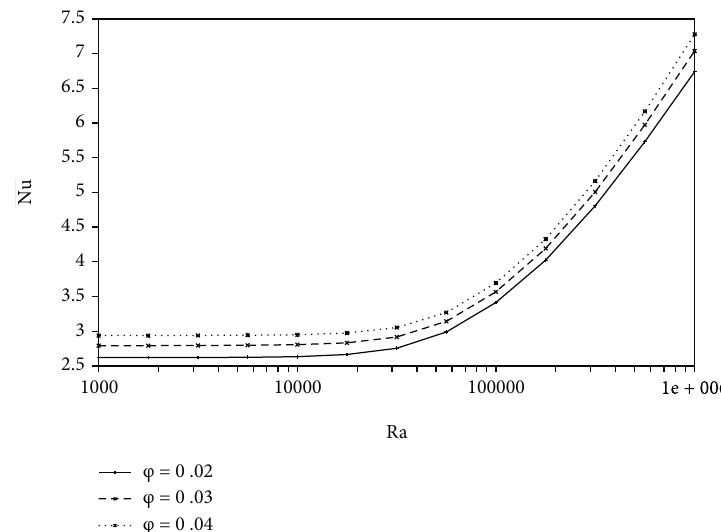
Figure 8: Plots of the average Nusselt number against Rayleigh number for the values of ϕ labelled on the fi gure at N = 3 and A = 0 : 2 .